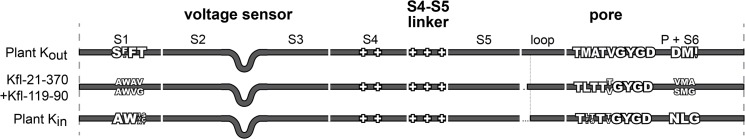
Simplified representation of structural features of Kv-like channels from higher land plants and Klebsormidium.The core channel parts S1 to S6 are displayed including features that are characteristic for these K+ channel groups, like the extended S2-S3 and S5-P loops, conserved positive charges in S4 and the S4-S5 linker, and the selectivity filter motif TxxTxGYGD. Furthermore, two motifs in the transmembrane domains S1 and S6 are displayed. Outward-rectifying K+ channels contain an SFFT motif in S1, where inward-rectifying channels contain an AWxx motif. In S6 the characteristic DMI (Kout channels) and NLG (Kin channels) motifs are illustrated. In Klebsormidium the S6 motif is not yet specified, while the motif in S1 is that of Kin channels. The extended loop between S5 and P is two amino acids longer than in plant Kin channels and six amino acids shorter than the corresponding loop in plant Kout channels.